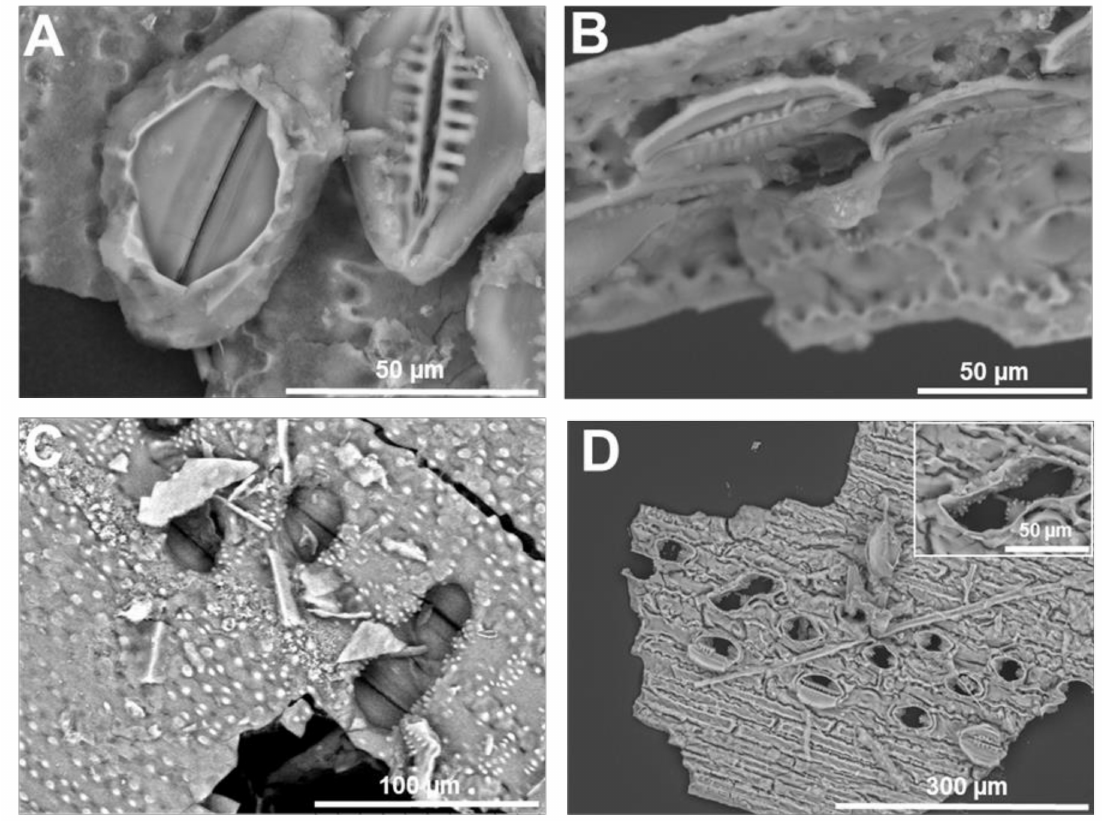
Figure 4. SEM images (topographic contrast) of di ff erent typologies of stomata on the stem of giant horsetail. ( A ) Two stomata possibly at di ff erent developmental stages (the one on the left is covered by a layer and is devoid of radiating ribs, while the stomata on the right is mature). ( B ) Transversal view of an adult stomata cut in half with details of the radiating ribs and neighbouring epidermal cells. ( C ) Sunken stomata interspersed among silicified papillae. ( D ) Naked and / or partially covered stomatal pores. Inset: detail of a bigger distorted stomatal pore with silicified projections. Images were taken using a HITACHI TM3000 TableTop scanning electron